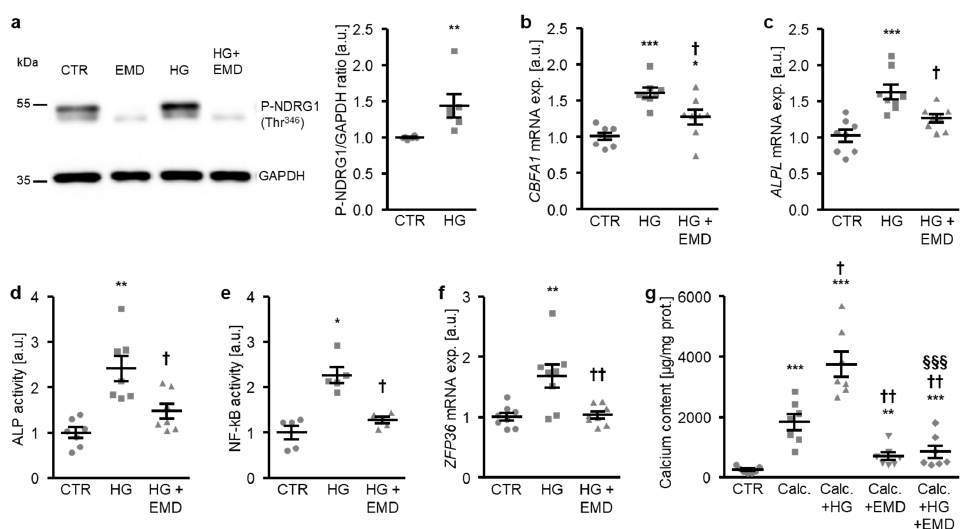
Figure 3. Inhibition of SGK1 blunts high glucose-induced osteogenic signaling and the calcification of HAoSMCs. ( a ) Representative original Western blots ( n = 6) showing phospho-NDRG1 (Thr 346 ) and GAPDH protein abundance in HAoSMCs following treatment with control (CTR) or 50 mM of glucose (HG) without and with 50 µ M of SGK1 inhibitor EMD638683 (EMD). Scatter dot plots and arithmetic means ± SEM ( n = 6; arbitrary units, a.u.) of the normalized phospho-NDRG1 (Thr 346 ) / GAPDH protein ratio in HAoSMCs following treatment with control (CTR) or 50 mM of glucose (HG). ( b , c ) Scatter dot plots and arithmetic means ± SEM ( n = 8; a.u.) of the CBFA1 ( b ) and ALPL ( c ) relative mRNA expression in HAoSMCs following treatment with control (CTR) or 50 mM of glucose (HG) without or with 50 µ M of SGK1 inhibitor EMD638683 (EMD). ( d ) Scatter dot plots and arithmetic means ± SEM ( n = 7, a.u.) of the ALP activity in HAoSMCs following treatment with control (CTR) or 50 mM of glucose (HG) without or with 50 µ M of SGK1 inhibitor EMD638683 (EMD). ( e ) Scatter dot plots and arithmetic means ± SEM ( n = 5; a.u.) of the NF- κ B-dependent transcriptional activity in HAoSMCs following treatment with control (CTR) or 50 mM of glucose (HG) without or with 50 µ M of SGK1 inhibitor EMD638683 (EMD). ( f ) Scatter dot plots and arithmetic means ± SEM ( n = 8; a.u.) of the ZFP36 relative mRNA expression in HAoSMCs following treatment with control (CTR) or 50 mM of glucose (HG) without or with 50 µ M of SGK1 inhibitor EMD638683 (EMD). * p < 0.05, ** p < 0.01, *** p < 0.001 significant vs. control HAoSMCs; † p < 0.05) †† p < 0.01 significant vs. HG-treated HAoSMCs. ( g ) Scatter dot plots and arithmetic means ± SEM ( n = 7, µ g / mg protein) of the calcium content in HAoSMCs following treatment with control (CTR) or calcification medium (Calc.) alone and together with 50 mM of glucose (HG) and without and with 50 µ M of SGK1 inhibitor EMD638683 (EMD). ** p < 0.01, *** p < 0.001 significant vs. control HAoSMCs; † p < 0.05, †† p < 0.01 significant vs. Calc.-treated HAoSMCs; §§§ p < 0.001 significant between Calc. + HG and Calc. + HG + EMD-treated